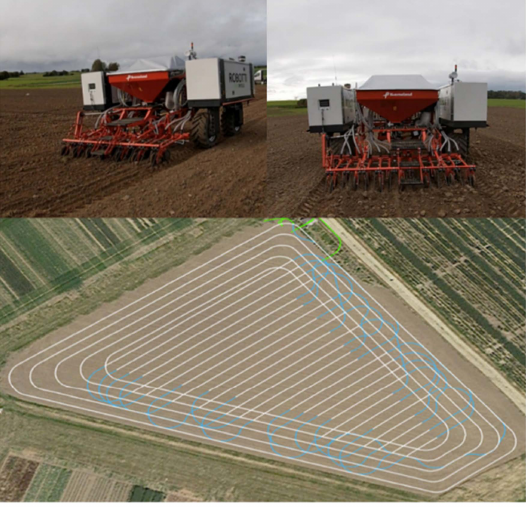
Figure 9. Seeding operation with the robot in a small triangle field. Table 8. The results of in-field operation for the first scenario for the robot and the tractor with different working